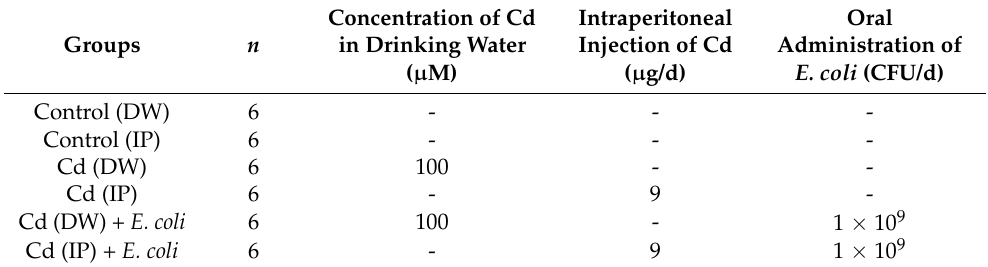
Table 2. Experimental protocol of Cd-exposed mice treated with E. coli